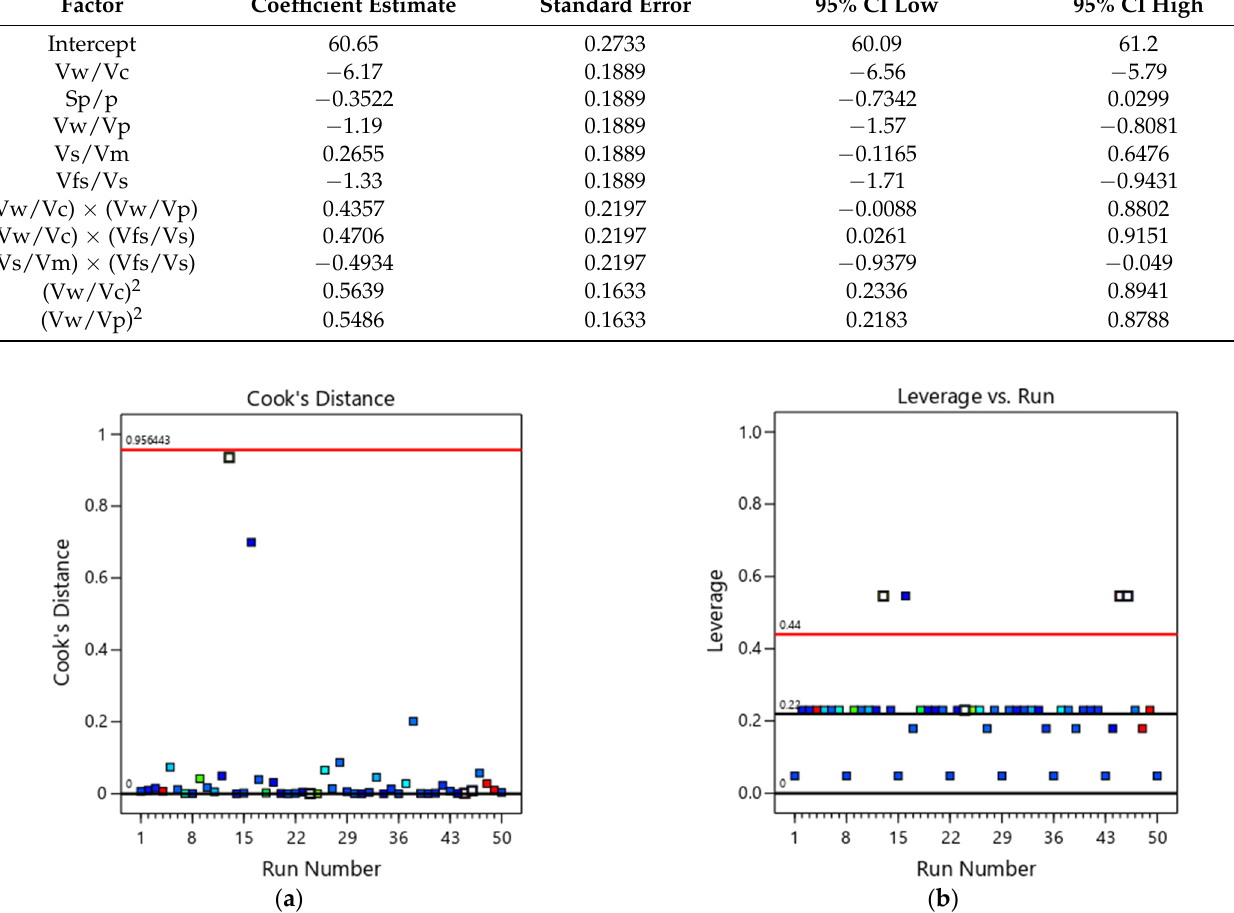
Figure 8. Influence of each factor on fresh state responses, in which (+) Positive effect in response models; ( − ) Negative e ff ect in response model (see Table 13).